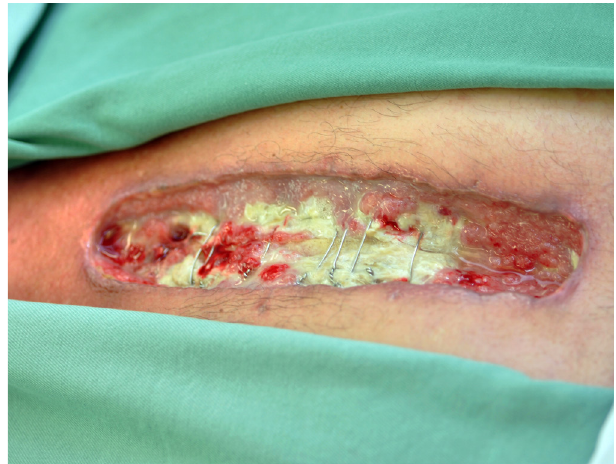
Fig. 1A - Male patient, 60 years of age with post-CABG dehiscence in the 37 th postoperative day, treated with fasciocutaneous flap of bilateral pectoralis major muscle.